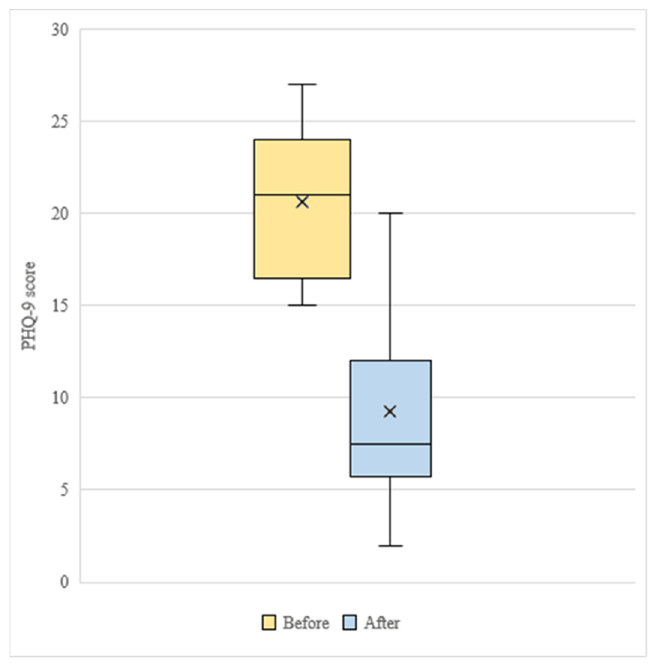
Figure 2. Boxplot for PHQ-9 scores before and after the intervention. Vertical lines represent medians, and crosses represent means.